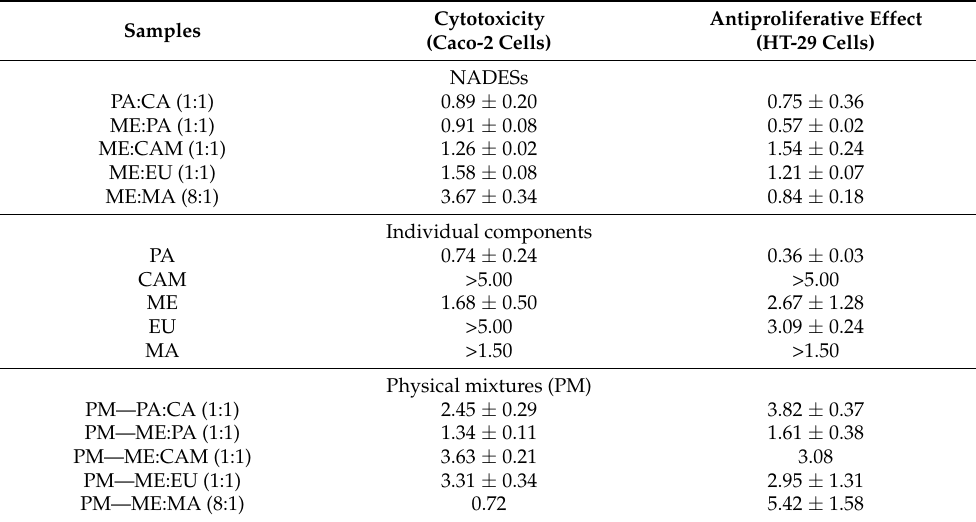
Table 3. EC 50 values (mg/mL) for individual components, NADESs and physical mixtures in Caco-2 and HT-29 Cells, after an incubation period of 24 h.